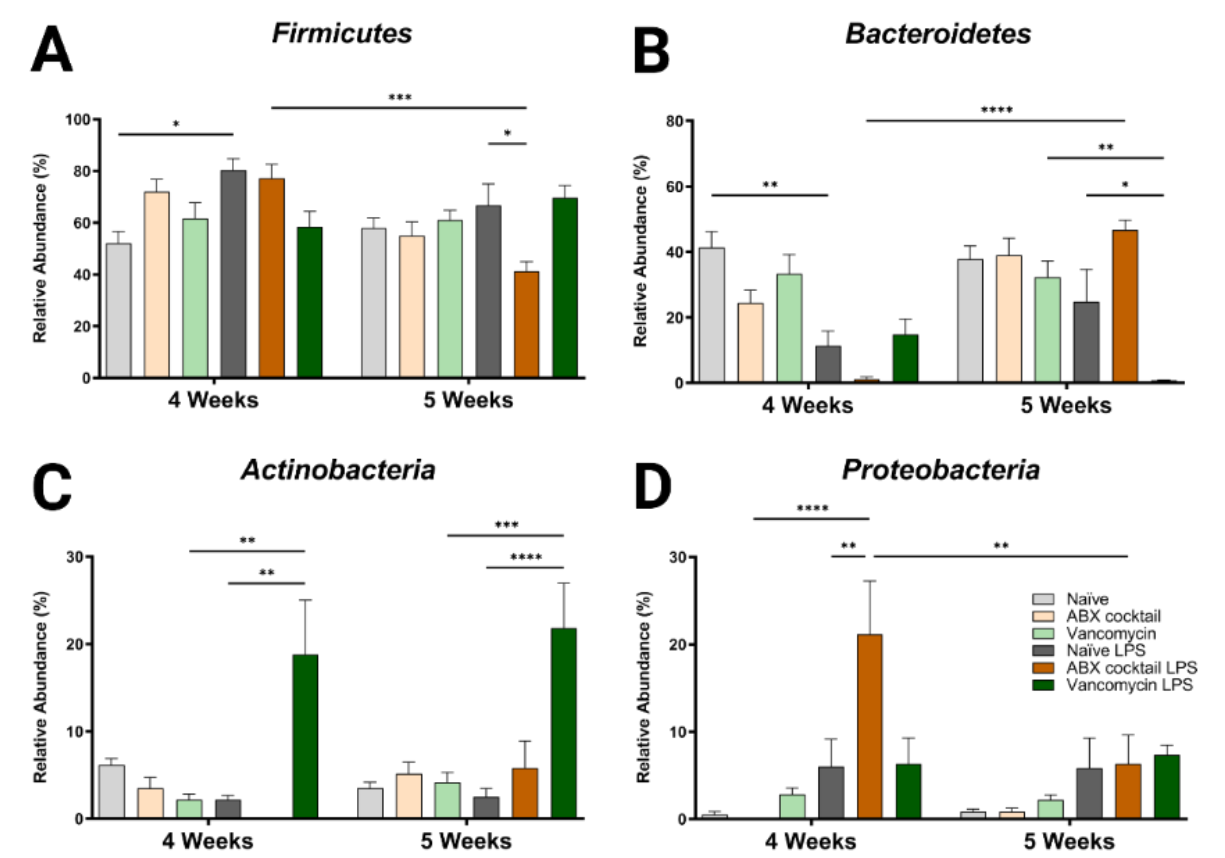
Figure 2. Maternal ABX alters offspring phylum populations. Relative abundances of ( A ) Firmicutes , ( B ) Bacteroidetes , ( C ) Actinobacteria, and ( D ) Proteobacteria at 4 and 5 weeks. Naïve = light grey, ABX cocktail = light brown, Vancomycin = light green, Naïve LPS = grey, ABX cocktail LPS = brown and Vancomycin LPS = green. n = 6 for all groups. Two-way ANOVA followed by Tukey post-correction test for multiple comparisons where values represent means ± SEM, * p ≤ 0.05, ** p ≤ 0.01, *** p ≤ 0.001 and **** p ≤ 0.0001.